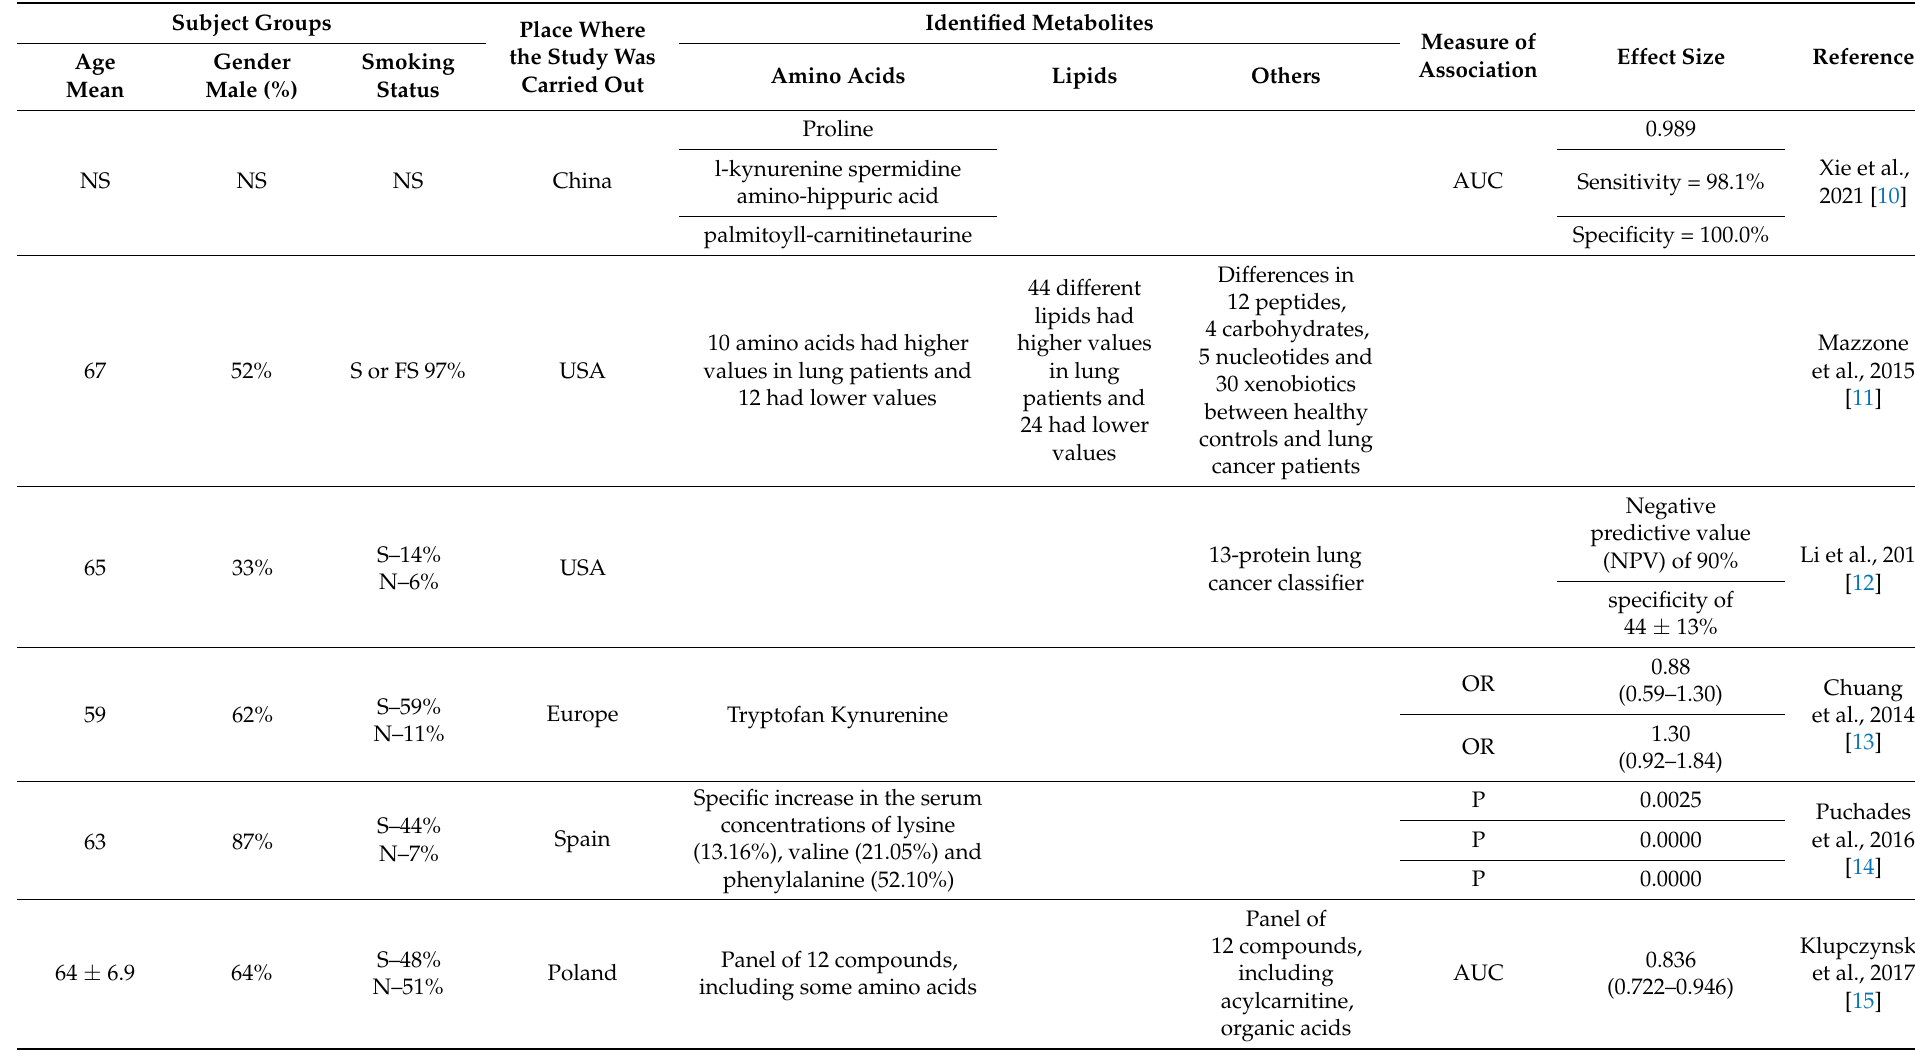
Table 3. Characteristics of the included studies, with the main alterations in metabolites/metabolomic profiles